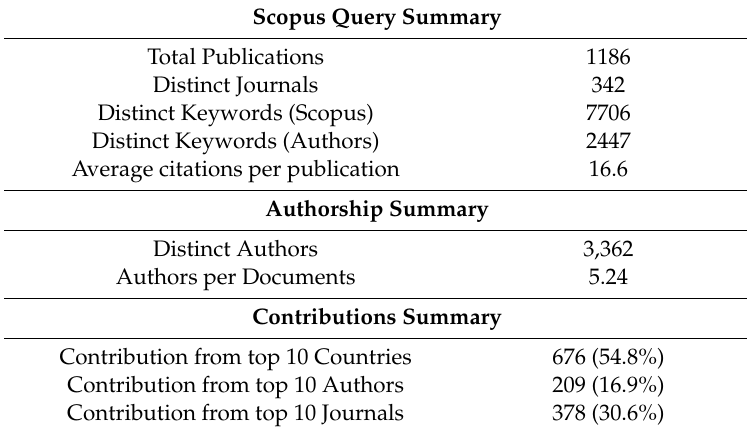
Table 1. Summary data from Scopus query for inland water quality remote